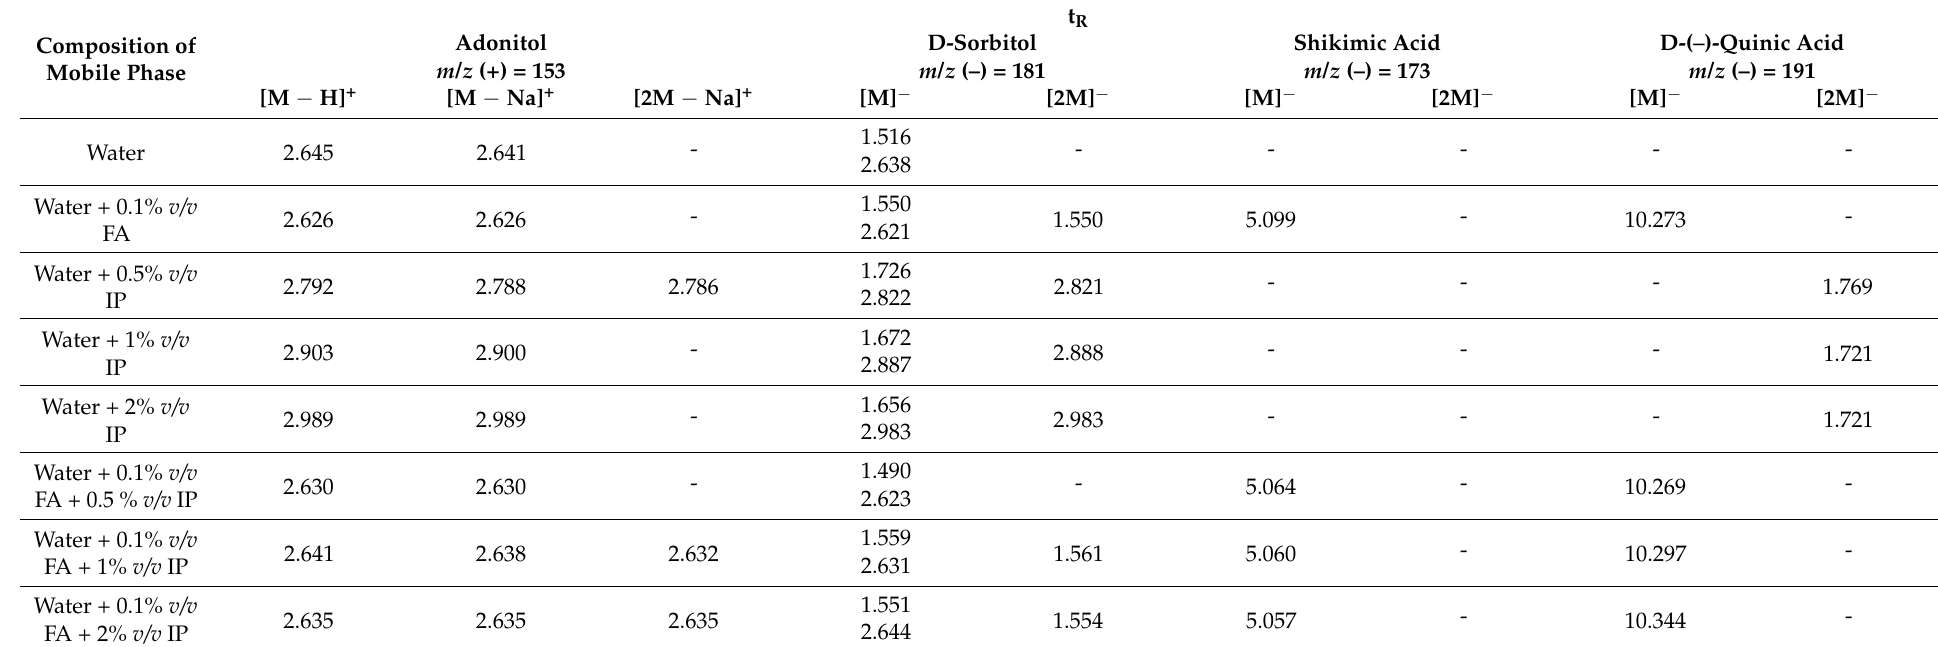
Table 2. Retention times of analyzed cyclitols at different mobile